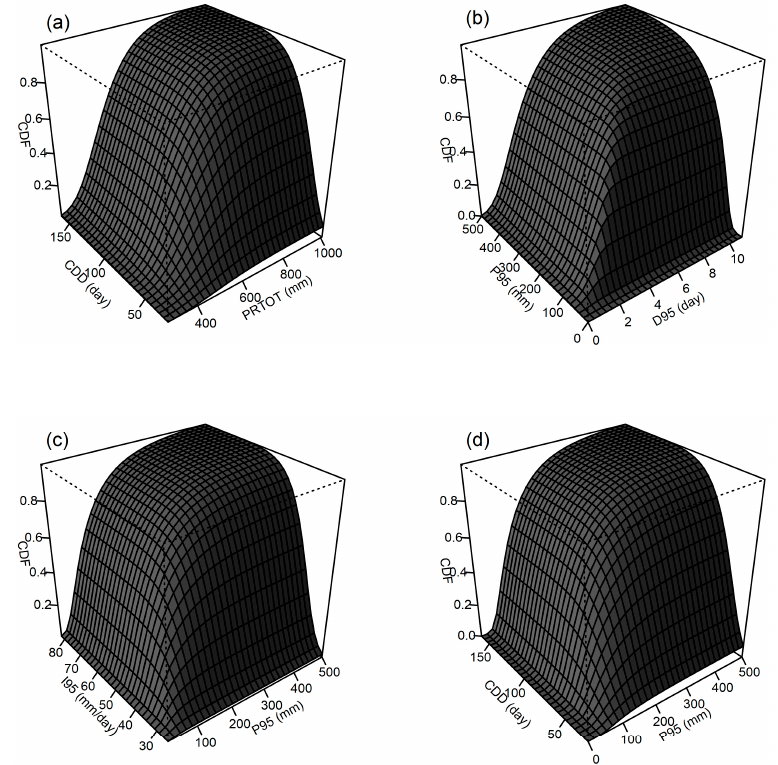
combinations at Qindu Station: ( a ) PRTOT, CDD, ( b ) {D95, P95}, ( c ) {P95, I95}, and ( d ) {P95, Figure 4. Joint cumulative distribution functions (CDFs) based on the best fitted copulas for four indicator combinations of {PRTOT, CDD}, {D95, P95}, {P95, I95}, and {P95, CDD} at Qindu Station.